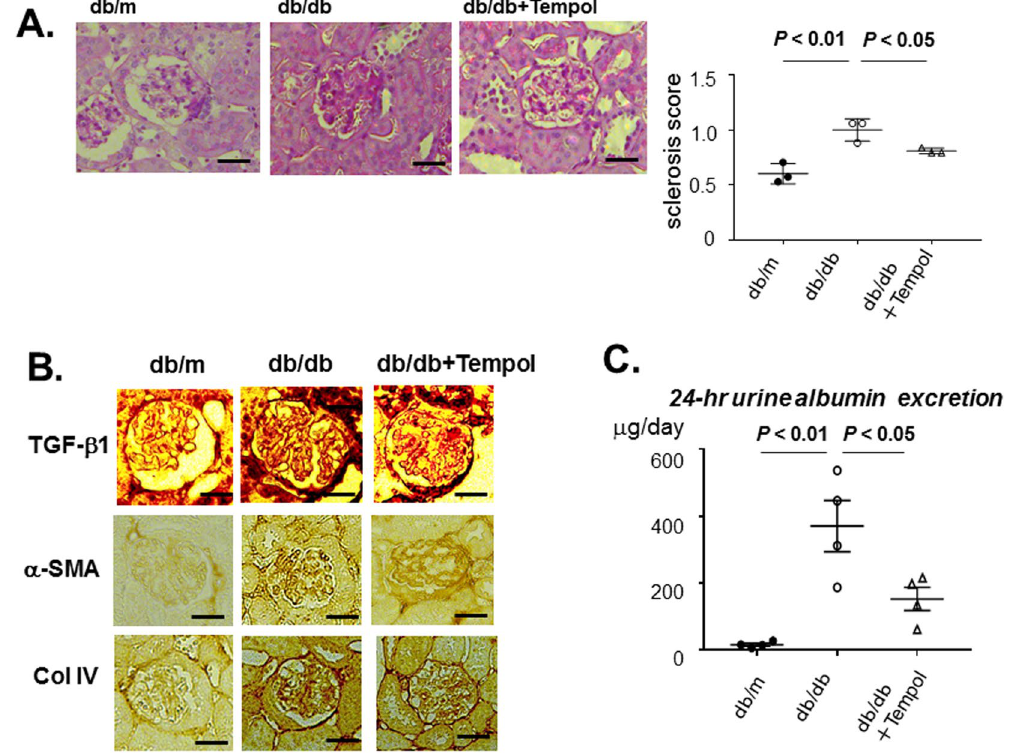
Figure 7. The effect of anti-oxidants on glomerulosclerosis in db/db mice. ( A ) PAS staining of glomeruli from 15-week-old db/m , db/db , and db/db mice treated with Tempol for 8 weeks. Scale bar, 20 µ m. Mesangial sclerosis is significantly increased in db/db mice compared to db/m mice, but Tempol significantly decrease in db/db mice. Semi-quantitative glomerulosclerosis scores of 20 glomeruli each from three mice per group. Data represent the mean ± SEM. n = 3. Filled circle: db/m mice; open circle: db/db mice; open triangle: db/db + Tempol. ( B ) Representative images of immunostaining of TGFB1, α− smooth muscle actin ( α -SMA), and type IV collagen (Col IV) in glomeruli from 15-week-old db/m , db/db , and db/db mice treated with Tempol for 8 weeks. Treatment with Tempol attenuated increased immunostaining of TGFB1, α -SMA and Col IV in the glomeruli of db/db mice. Scale bar, 20 µ m. ( C ) 24-hr urinary albumin excretion at 15-week old db/m , db/db and db/db treated with Tempol for 8 weeks. Urinary albumin excretion is significantly increased in db/db mice compared with db/m mice, but treatment with Tempol significantly reduce the increased urinary albumin in db/ db mice. Data represent the mean ± SEM. n =